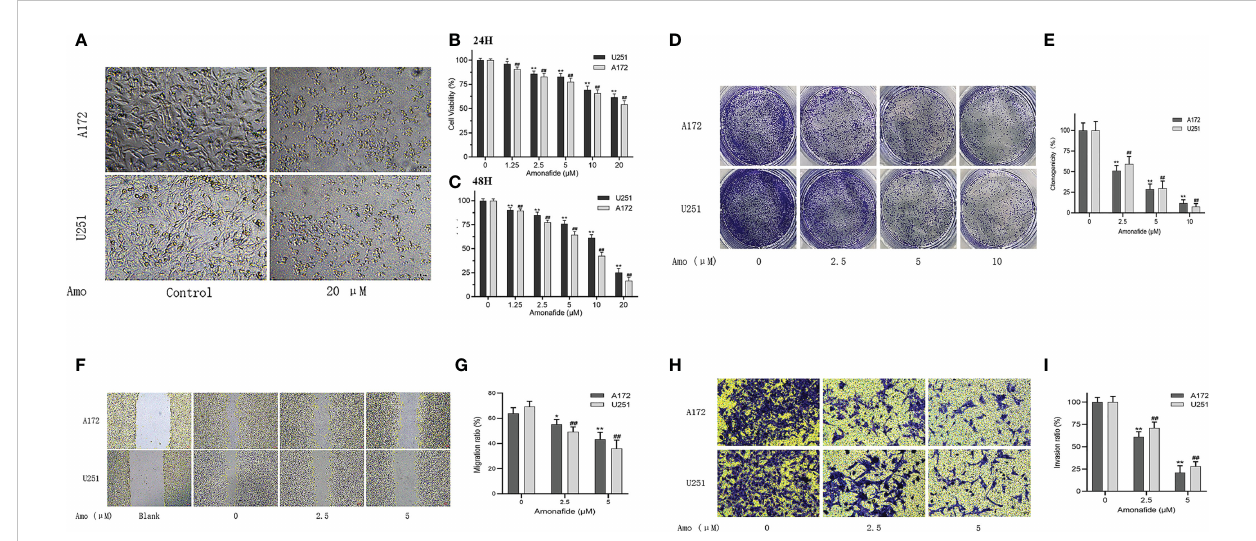
FIGURE 10 Amonifade inhibits the proliferation, invasion and migration of U251 and A172 cells. (A) Effect of Amonifade at concentrations of 0 m M and 20 m M on proliferating cell viability of U251 and A172 cells; (B, C) Effect of Amonifade at concentrations of 0 m M, 1.25 m M, 2.5 m M, 5 m M, 10 m M and 20 m M on proliferating cell viability of U251 and A172 cells after 24 and 48 hours of incubation; (D, E) Effect of different concentrations of Amonifade on the clonogenic ability of U251, A172 cells after 24 h of treatment; (F, G) Effect of different concentrations of Amonifade on the healing ability of U251, A172 cells after 24 h of treatment. (H, I) Effect of different concentrations of Amonifade treatment for 24 h on the mailbox of U251, A172 migration invasion. The * symbol means P values < 0.05, the ** symbol means P values < 0.01, and the ## symbol means P values